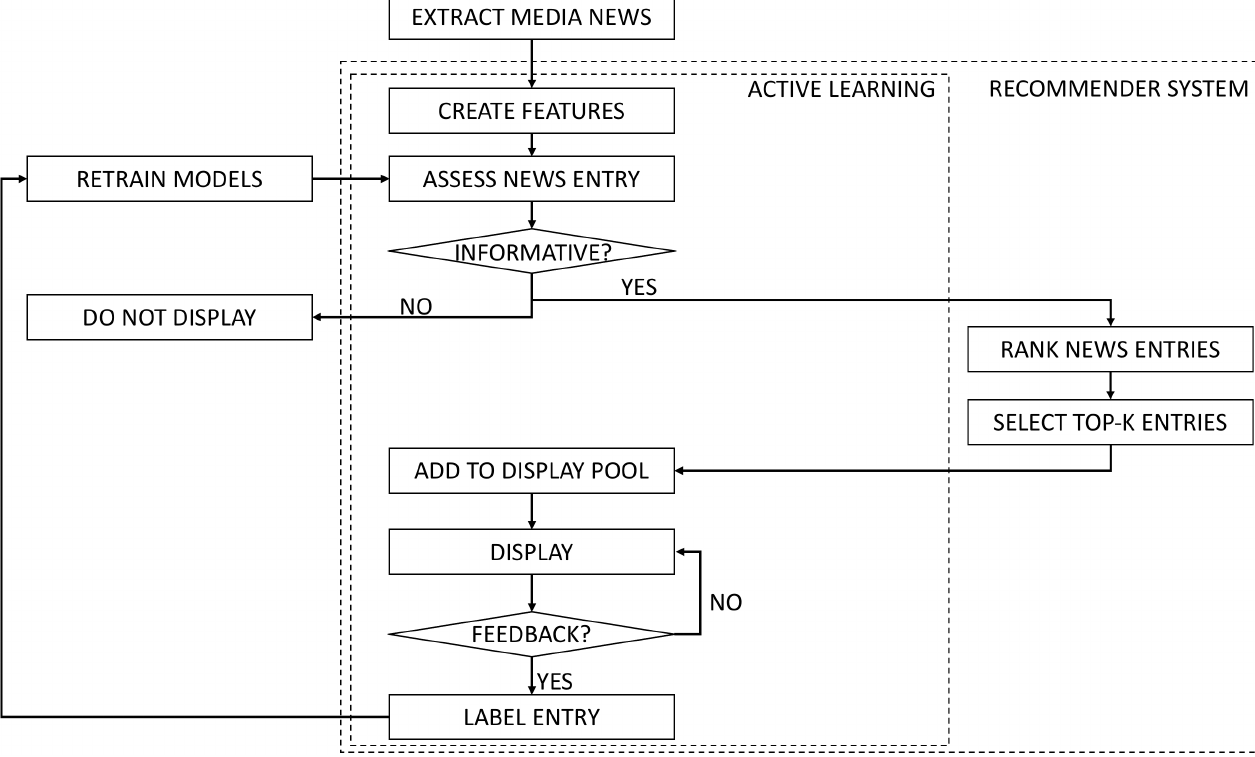
Figure 3. Fluxogram, showing how active learning and recommendations are implemented for media news event